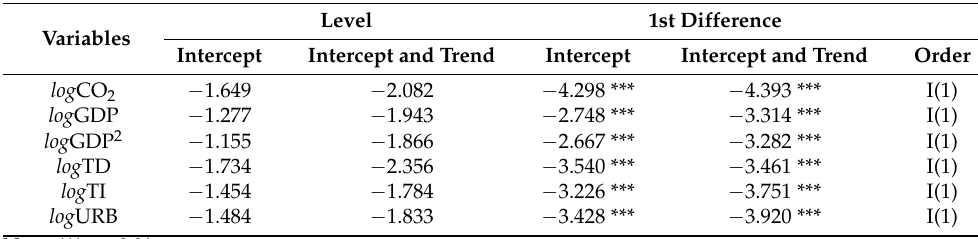
Table 6. Results of the unit root test panel.